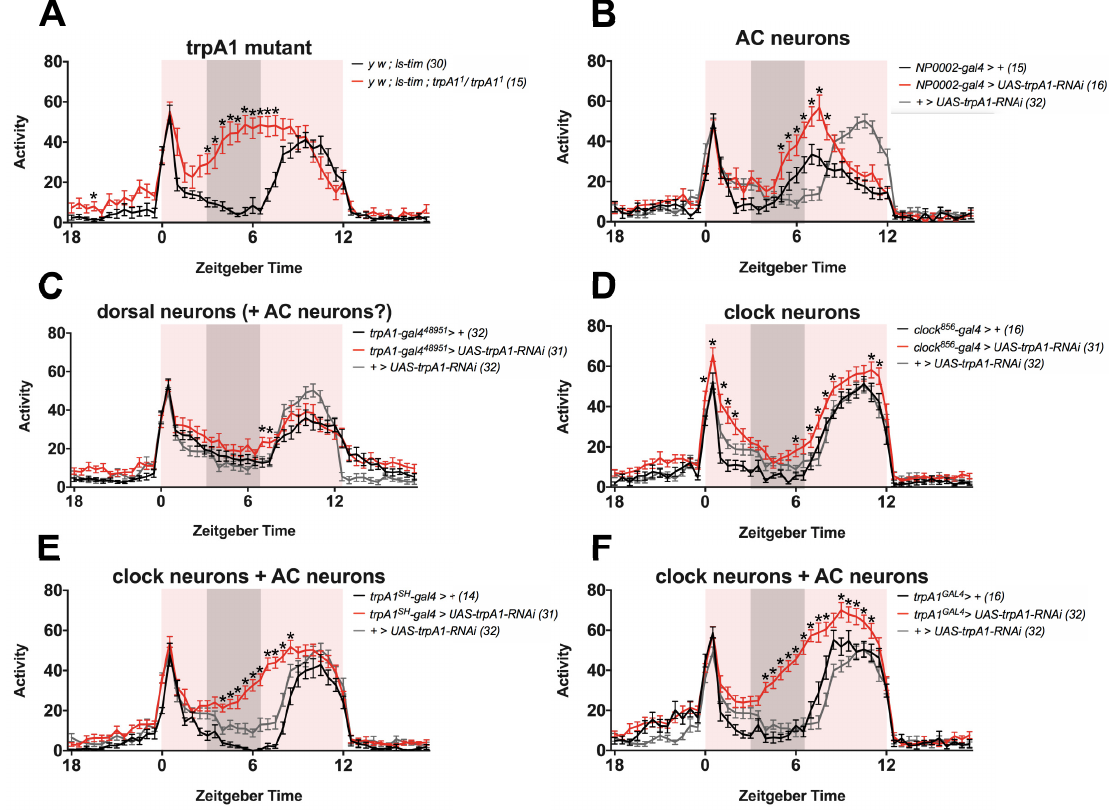
Figure 3. Investigation of the TRPA1 circuit that regulates siesta activity levels during 29 ◦ C:20 ◦ C temperature cycles in constant darkness (DDTC), using trpA1 knock-down. All figure panels show average activity profiles of indicated genotypes, during the last four days of 29 ◦ C:20 ◦ C TC. Red/white background shadings indicate warm/cold phases. Grey bar (ZT 3-6.5) indicates the siesta. n numbers for each genotype are given in the legend. Error bars represent SEM ( A ) activity profiles of wild-type and trpA1 1 mutants. Multiple t -tests were used to determine significant differences between genotypes at each time point. ∗ means p <0.05; ( B – F ) activity profiles of flies with knock-down of trpA1 in candidate tissues (red) and gal4 (black) and Upstream Activation Sequence (UAS) (grey) control flies. See Table 1 for expression patterns of the gal4 drivers used. trpA1 48951 -gal4 is expressed in non-clock dorsal neurons and occasionally in AC neurons. Two-way analysis of variance and Tukey’s multiple comparisons test were used to determine significant differences between genotypes at each time point. ∗ means significantly different ( p <0.05) from both gal4 - and